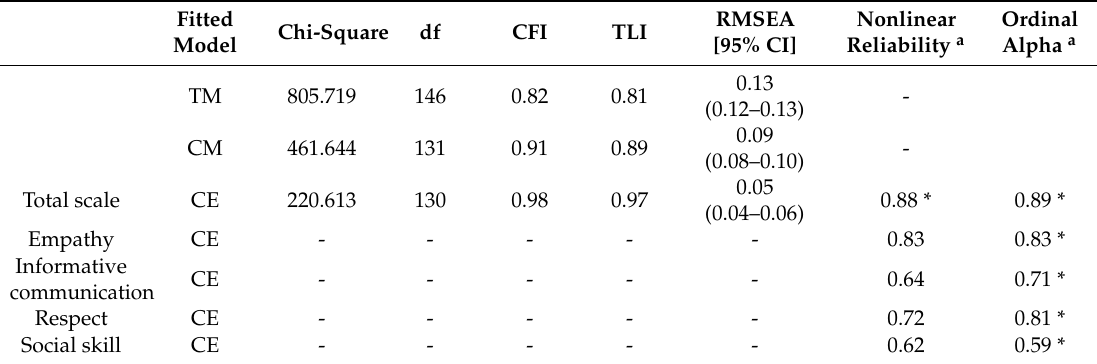
Table 2. Confirmatory analysis and internal reliability consistency ( n = 289).